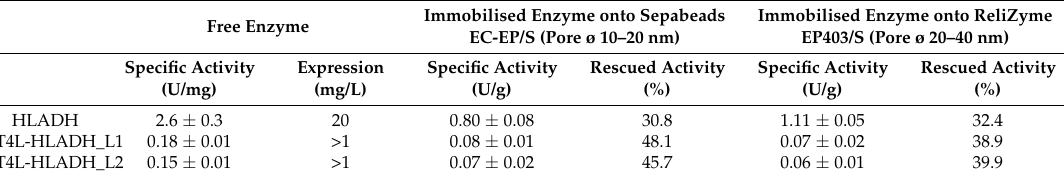
Table 3. Comparison of specific activities and expression levels of the original horse liver alcohol dehydrogenases (HLADH) and the two chimeric proteins in the free enzyme form. Specific activities of the resin following immobilisation of enzymes (1 mg enzyme /g resin ) and percentage of residual activity after immobilisation (24 h, room temperature, in 50 mM phosphate buffer pH 8) with respect to the free